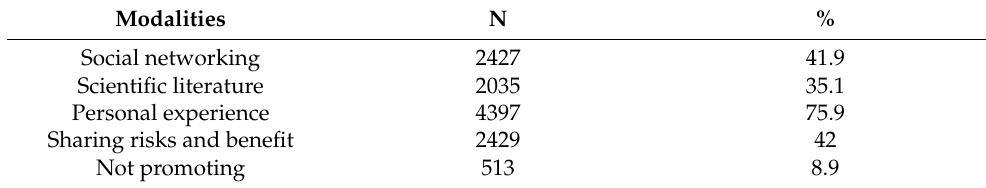
Table A2. Modalities of promotion of vaccine acceptance.